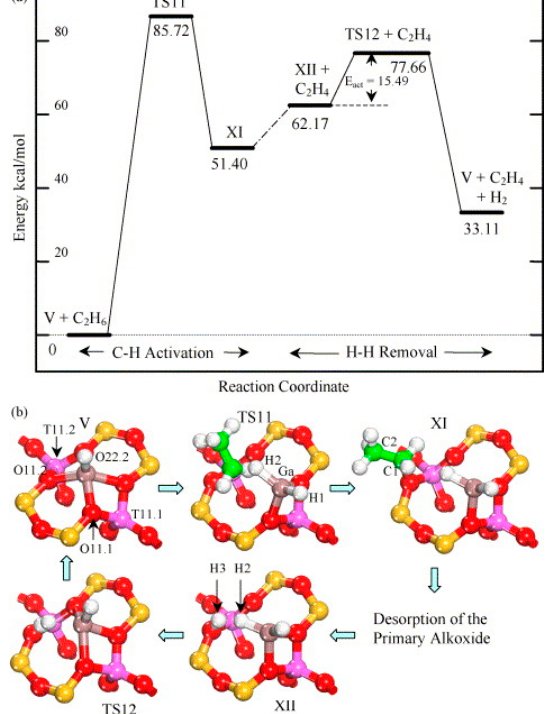
Figure 22. Carbenium activation path of ethane dehydrogenation on Z 2 − GaH 2+ species(V) in six-